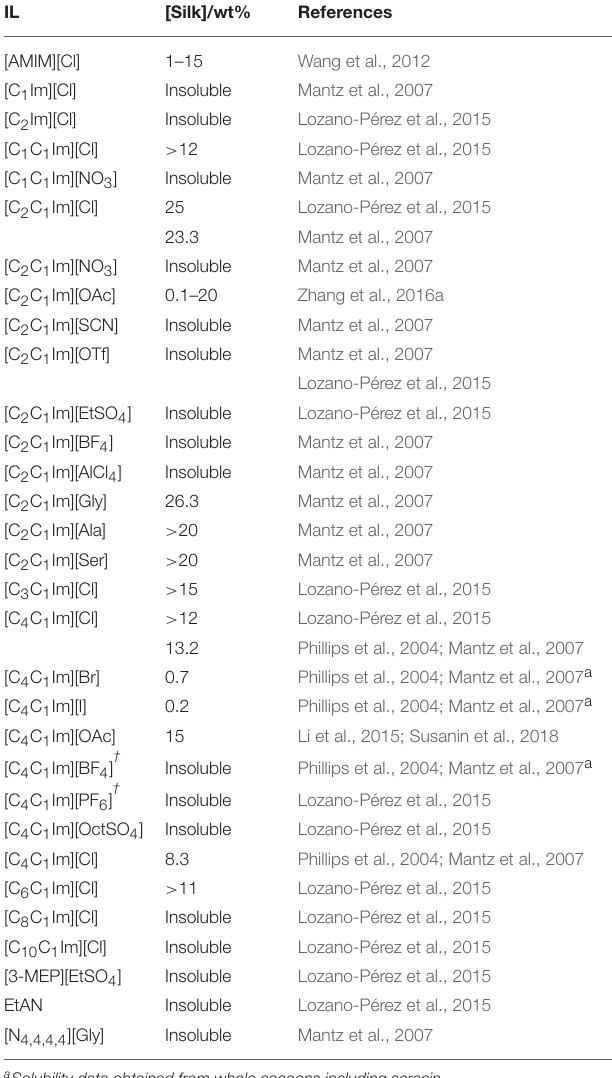
TABLE 2 | Ionic liquid data for silk solubility found in the literature.